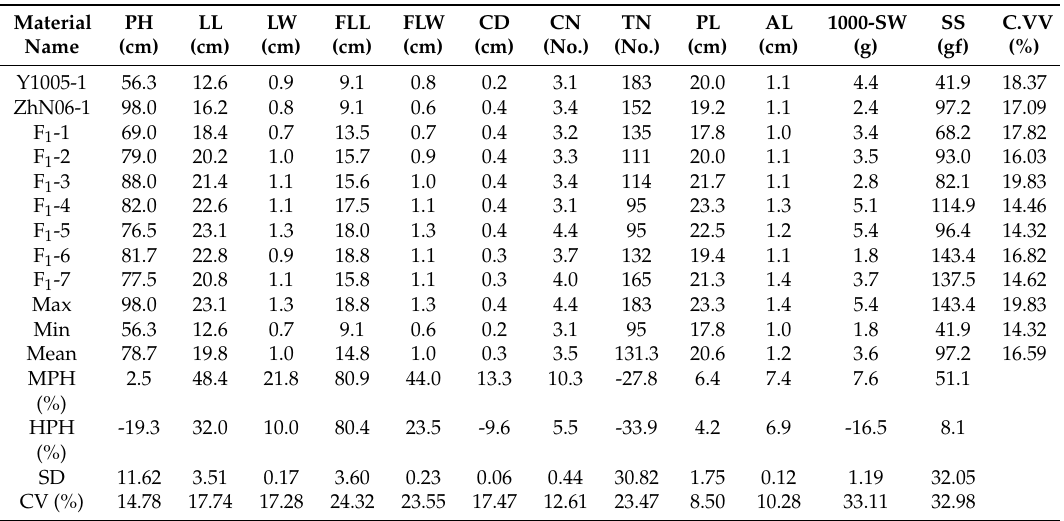
Table 6. Agronomic performance and the coefficients of variation (CV), mid-parent (MPH) and higher-parent heterosis (HPH) of hybrid population and